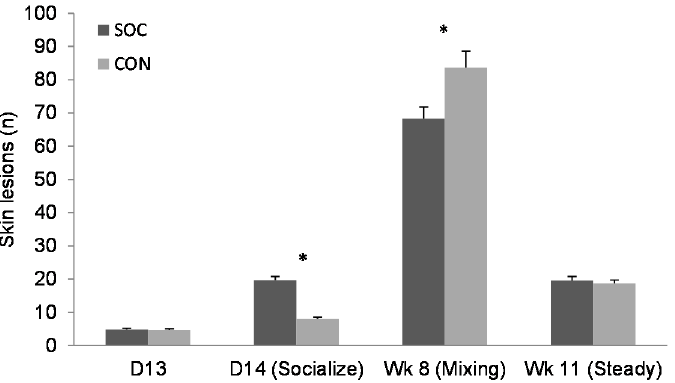
Figure 3. Untransformed means with SE for the number of skin lesions for the socialized group (SOC) and control group (CON). LS means with p -values are given in the text. * Means differ by p <